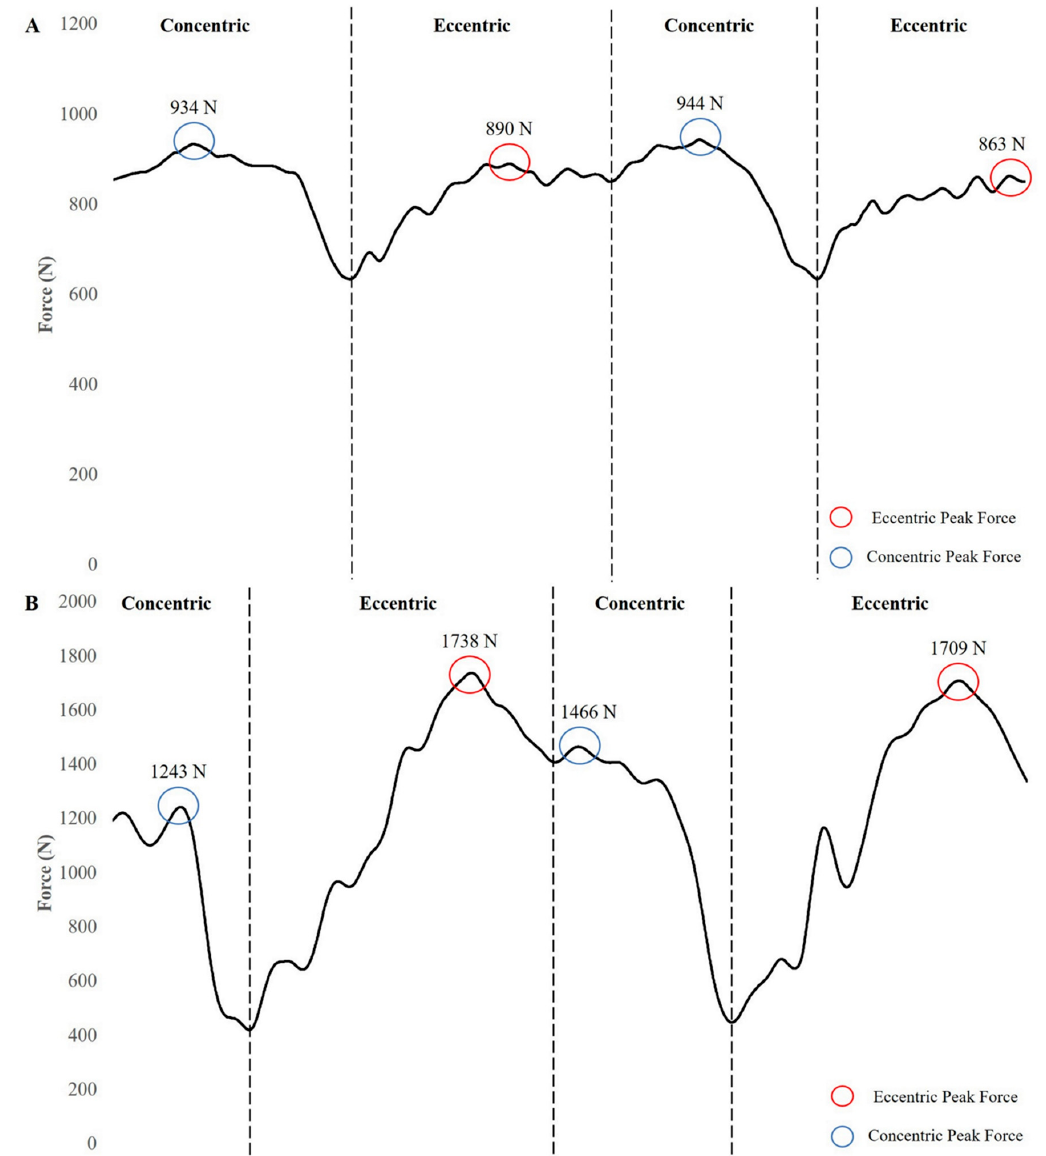
Figure 2. Force–time curves of flywheel squats performed by a healthy, 31 year old male using a 0.050 kg ∙ m 2 inertial load with a slow ( A ) (~ 3 s) and fast ( B ) (< 1 s) concentric action.